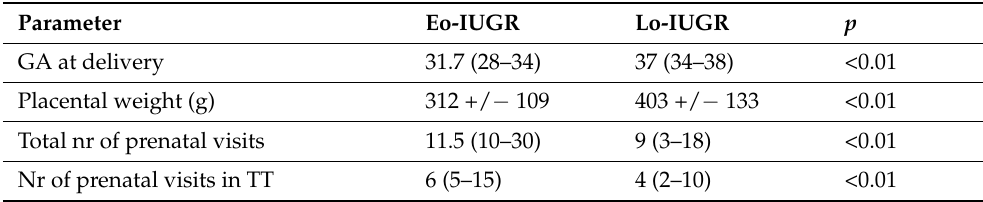
Table 3. Comparison between gestational age at delivery and the total number of prenatal visits and visits in the third trimester in the two groups.